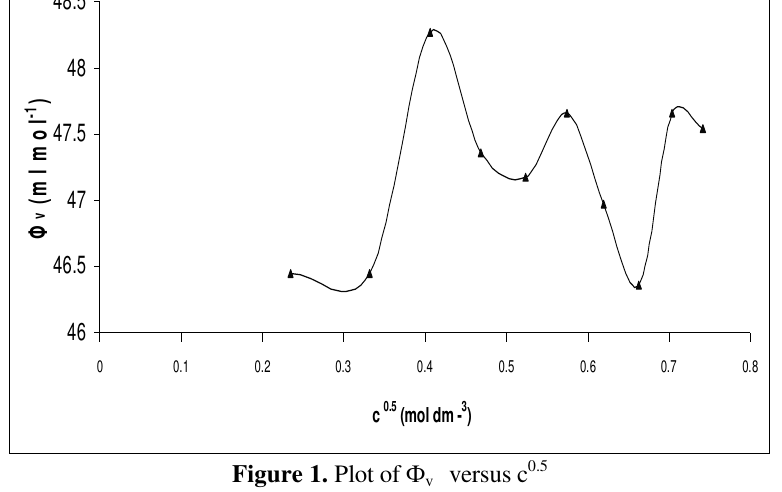
Figure 1. Plot of (cid:4) v versus c 0.5